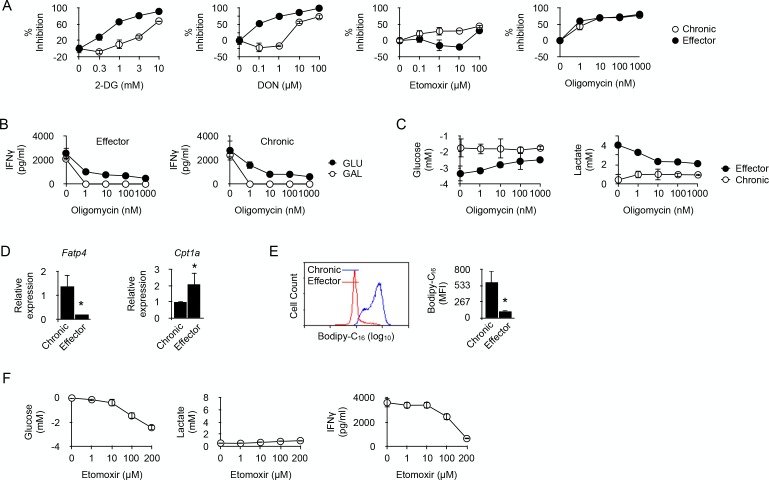
Fatty acid oxidation supports the energy demand required for IFNγ production in long-term chronic CD4+ T cells.(A) Effector or chronic CD4+ T cells were stimulated with anti-CD3/CD28 antibodies with or without 2-DG, DON, Etomoxir or oligomycin. After 48 hr, culture supernatants were harvested and IFNγ concentrations were determined by ELISA. Percent inhibition were calculated as described in Materials and methods. Data (mean ± SEM) were calculated from five replicated cultures and are representative of three independent experiments. (B) IFNγ production by effector (left) and chronic (right) T cells stimulated with anti-CD3/CD28 antibodies for 48 hr in medium containing glucose or galactose, in the presence of oligomycin. Data (mean ± SEM) were calculated from five replicated cultures and are representative of three independent experiments. (C) Glucose consumption (left) and lactate production (right) in cultures of effector or chronic T cells stimulated with anti-CD3/CD28 antibodies for 48 hr in the presence of oligomycin. Data (mean ± SEM) were calculated from five replicated cultures and are representative of three independent experiments. (D) Ex vivo relative expression of FATP4 and CPT1a mRNA in chronic or effector T cells. Data (mean ± SEM) were calculated from five mice per group and are representative of two independent experiments. * indicates p=0.0079 by the Mann-Whitney test. (E) Bodipy-C16 uptake by chronic or effector T cells. Data (mean ± SEM) were calculated from five replicated cultures and are representative of two independent experiments. * indicates p=0.0079 by the Mann-Whitney test. (F) Glucose consumption (left panel), lactate (middle panel) and IFNγ production (right panel) by chronic CD4+ T cells stimulated for 48 hr by anti-CD3/CD28 antibodies in the presence of FAO inhibitor Etomoxir. Data were calculated from five replicated cultures and are representative of two independent experiments.